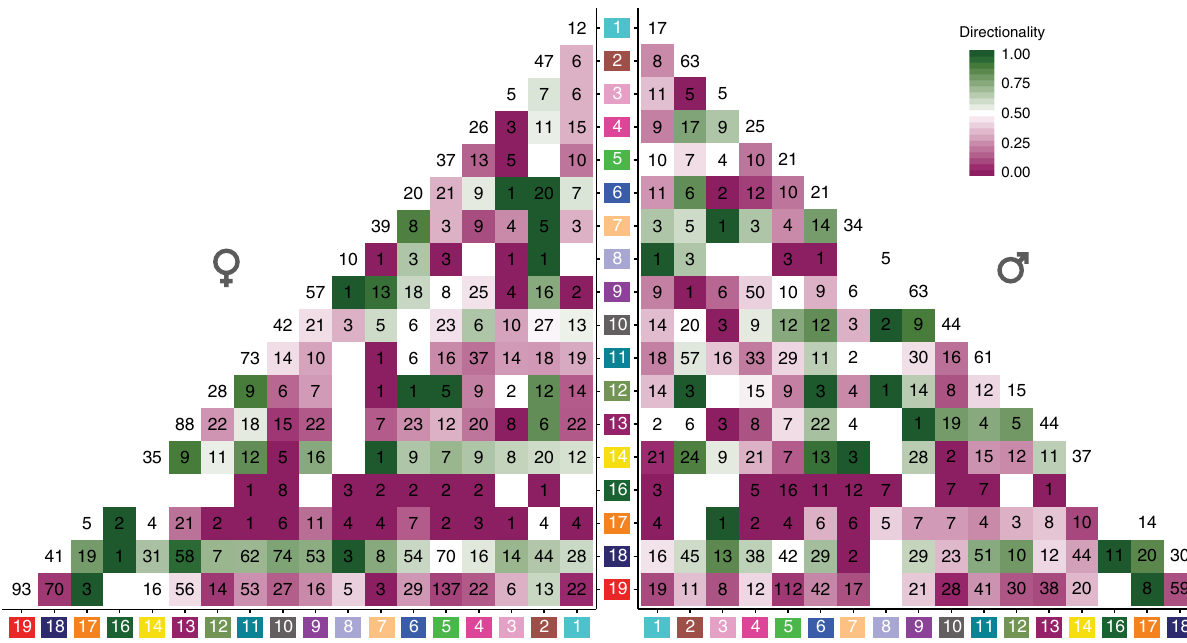
Fig. 3 Temporal diagnosis co-occurrence across ICD-10 chapters. The distribution of 3186 and 3721 temporal diagnosis co-occurrences across ICD-10 chapters in men and women, respectively (non-sex-speci fi c diagnoses). The color scale indicates the percentage of the pairs that has the temporal directionality from the horizontal chapter to the vertical chapter. Numbers in the boxes indicate the breakdown of the overall co-occurrence fi gures